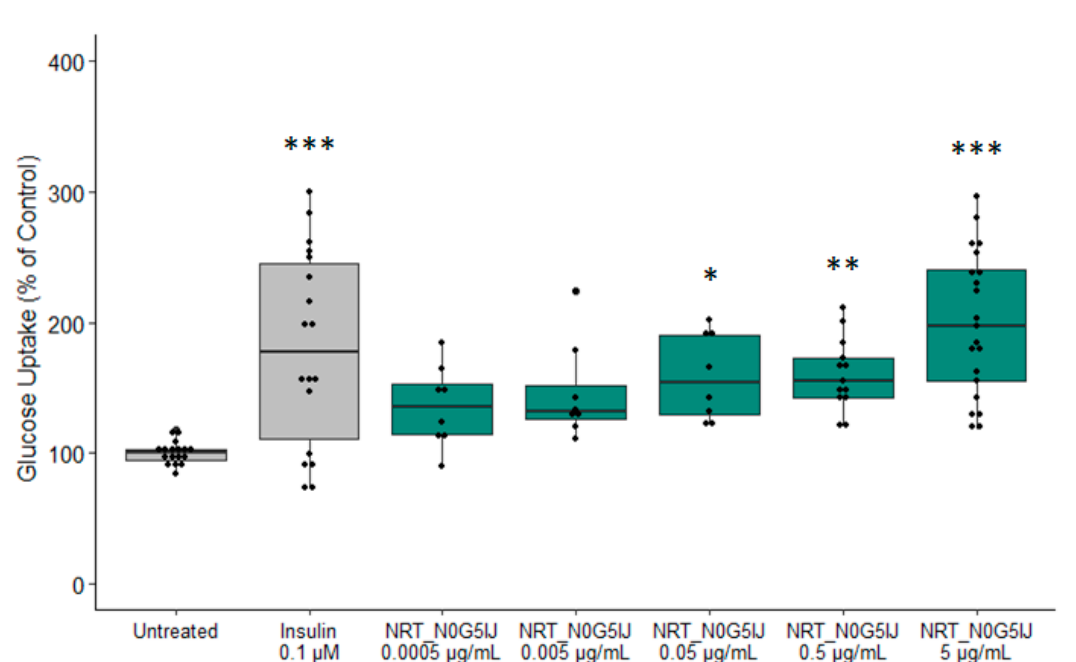
Figure 1. NRT_N0G5IJ significantly increases glucose uptake in human skeletal cells. Skeletal muscle cells were stimulated for 20 mins with insulin (0.1 µM) or a dose of NRT_N0G5IJ (as indicated) prior to glucose uptake assessment with a minimum of three independent replicates (* p < 0.05; ** p < 0.01; *** p < 0.001).